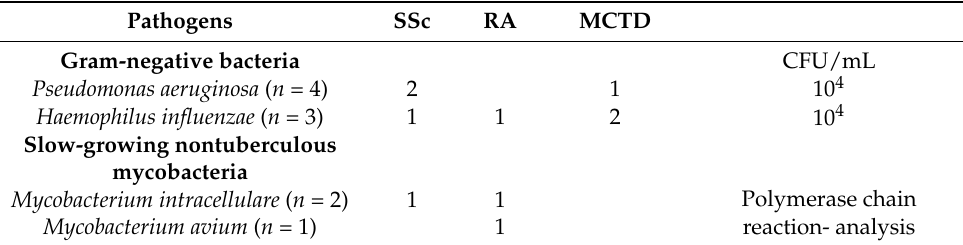
Table 2. Microorganisms found in the broncho-alveolar lavage fluids (>5 mL) of the patients